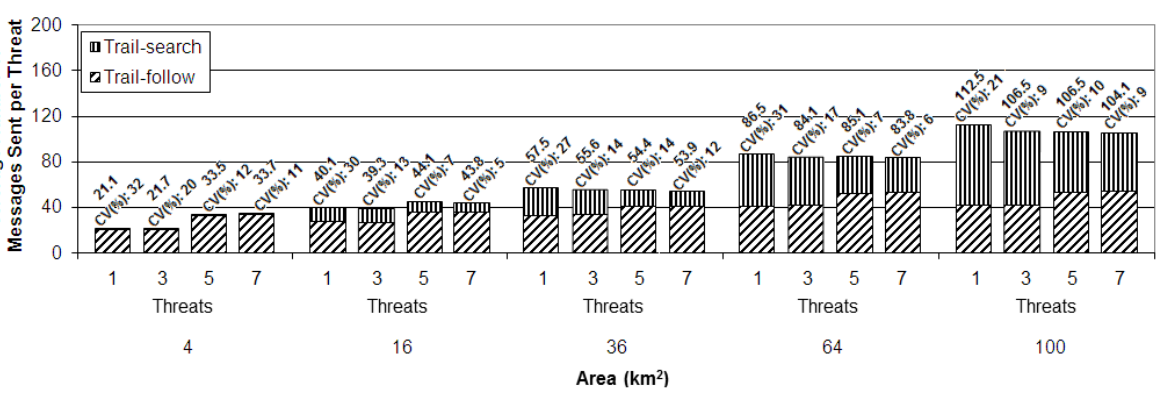
Figure 12. Results of the cost metric in terms of the average number of messages sent per threat for the simulations with 2 Unmanned Aerial Vehicles and the four different numbers of threats (1, 3, 5 and 7).